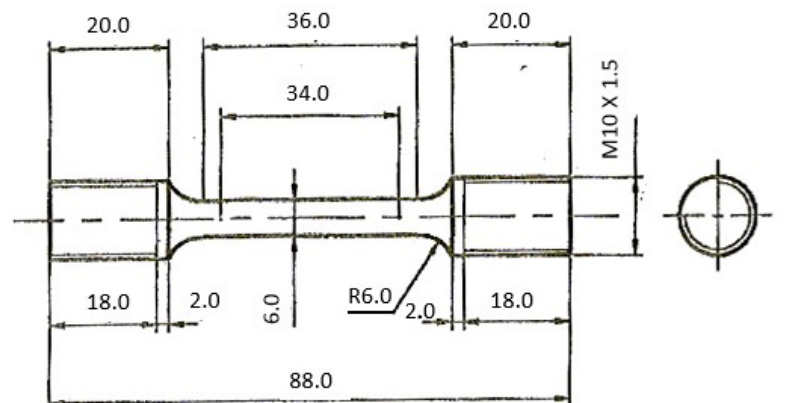
Figure 2. Schematic view of the specimens for hot tensile test 16